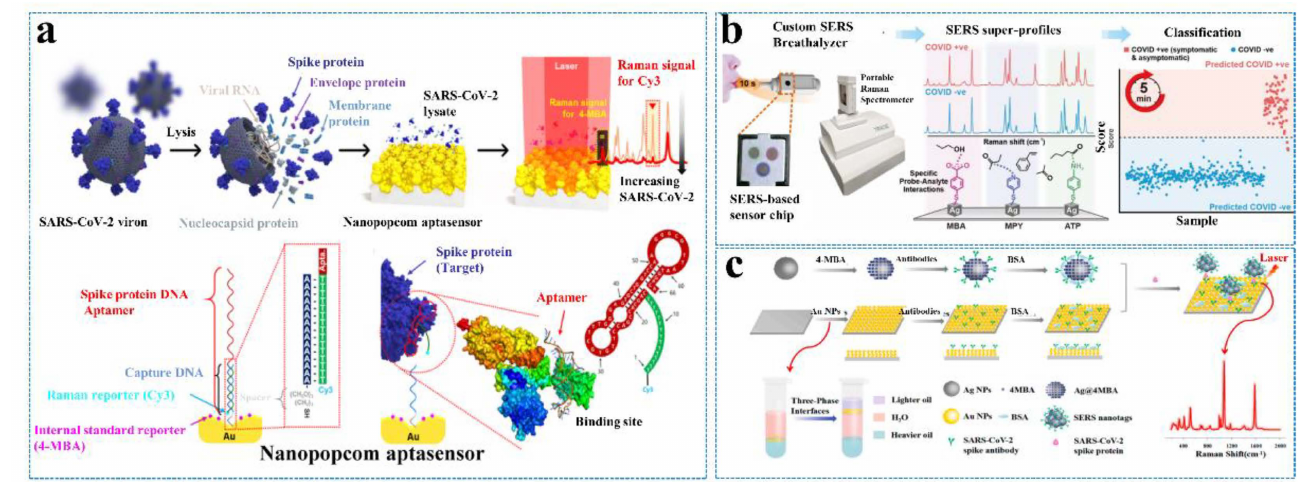
Figure 7. ( a ) Schematic illustration of the quantitative evaluation of SARS-CoV-2 using the SERS- based biosensor. Reprinted with permission from ref. [80]. Copyright 2021, American Chemical Society. ( b ) Overview of the SERS-based biosensor to identify COVID-19 patients using their breath volatile organic compounds (BVOCs). Reprinted with permission from ref. [81]. Copyright 2022, American Chemical Society. ( c ) Schematic illustration of the SERS-based immunoassay. Reprinted with permission from ref. [85]. Copyright 2021,